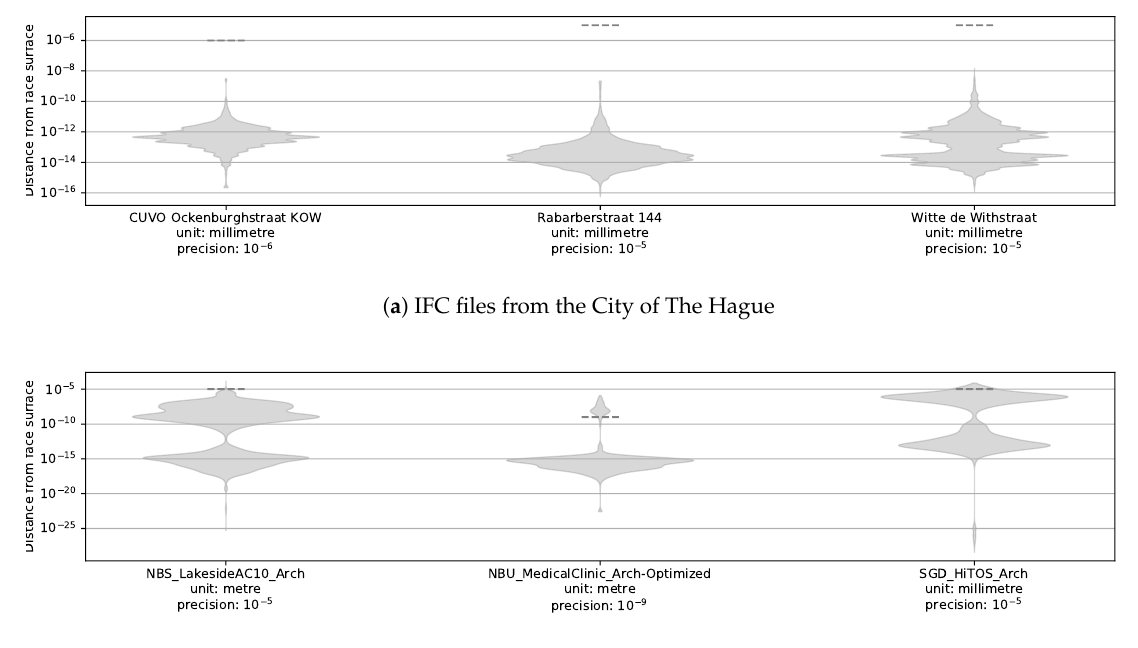
( b ) A set of three arbitrary public test models from data.duraark.eu Figure 7. Distributions of maximal vertex distance from underlying surface. To assess the distance from implicitly defined planes, a surface normal is found using Newell’s algorithm (see e.g., [34], p. 15). Arbitrary precision floating point arithmetic is used during computation. ( a ) shows that all distances are within the geometric precision defined in the file. As shown in ( b ) this is not always the